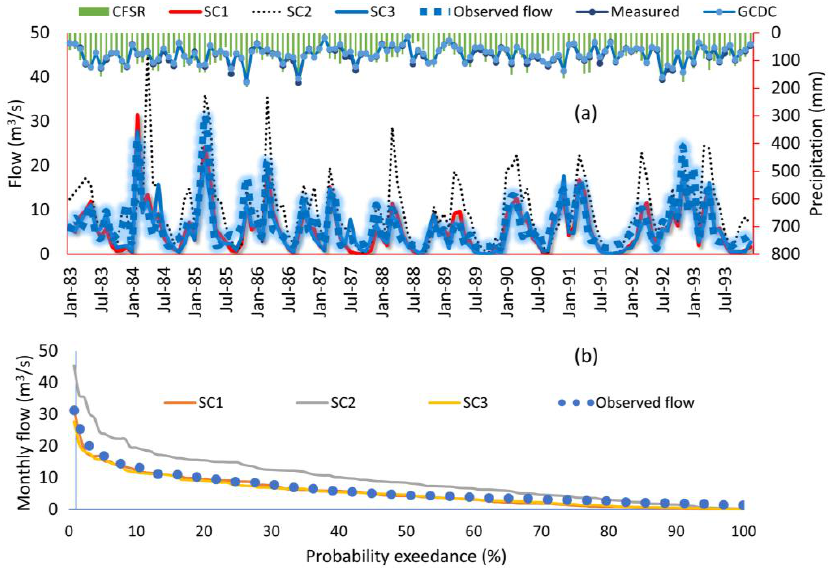
Table 3. Model performance statistics.